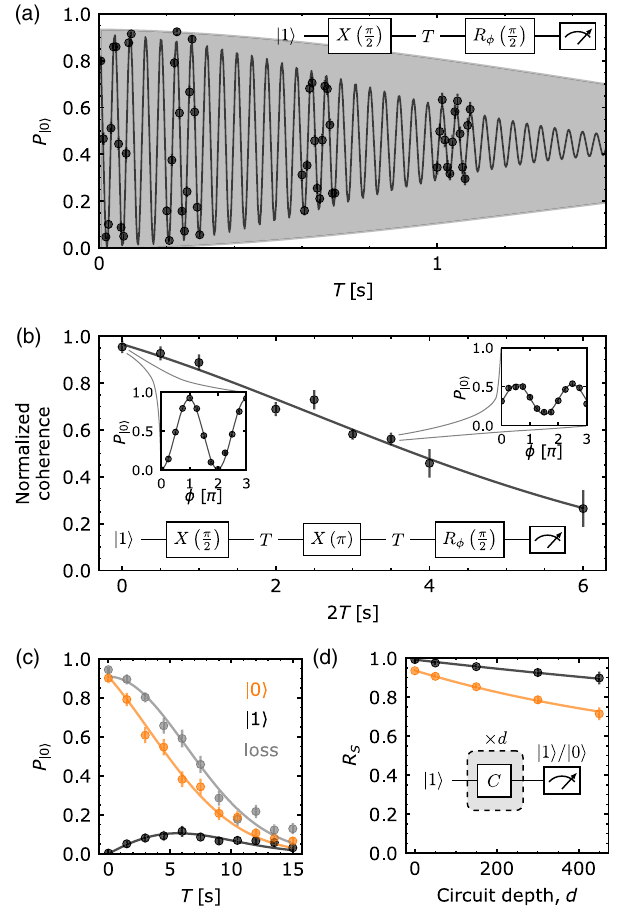
FIG. 3. Coherence measurements of the 171 Yb nuclear spin qubit. (a) Array-averaged Ramsey fringes with fitted 1 =e decay ¯ T (cid:2) 1 . 00 ð 4 Þ s [fitting sites individually yields an time of 2 ¼ average T (cid:2) 2 ¼ 1 . 24 ð 5 Þ s]. The gray shaded envelope indicates the contribution from a magnetic field gradient across the array. (b) Spin-echo measurement. The phase of the final π = 2 pulse is scanned for each wait time T , and the coherence is extracted from the visibility (insets) and normalized to the mean survival. The normalized coherence decays to 1 =e after a time T 2 ¼ 5 ð 1 Þ s. (c) Spin T 1 measurement. The orange (black) points show the probability to detect an atom in j 0 i following initialization in j 0 i ( j 1 i ). The gray points show survival probability without the spin readout sequence (i.e., atom loss), which decays to 1 =e after 9 . 0 ð 3 Þ s. Using survival-normalized populations, we infer T a ¼ 0 i 13 ð 2 Þ s and an intrinsic 1 =e spin flip time for each state: T j 1 ¼ T j 1 i 1 ¼ 27 ð 2 Þ s. (d) Randomized benchmarking of single-qubit rotations. Orange (black) points show the probability to obtain the correct result for sequences ending in j 0 i ( j 1 i ). From the decay rates, we obtain an average gate fidelity of 99.959(6)%. In all panels, the error bars show (cid:3) 1 σ statistical attribute the observed spin flip rate to leaked resonant light from a beam path without a mechanical shutter.